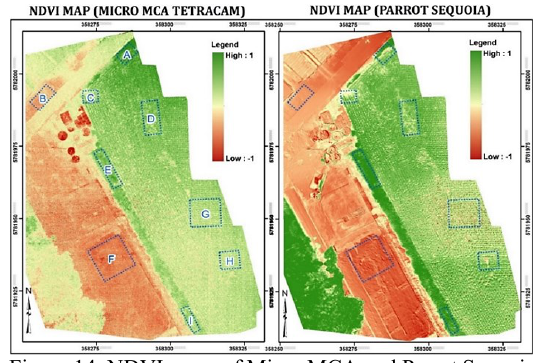
Figure 14. NDVI maps of Micro MCA and Parrot Sequoia The Vegetation Index (VI) response as extracted with PS and Micro MCA are highly correlated; the spatial averages of each zone recorded a positive correlation of 0.86. Despite the differences in GSD and in image quality between the two cameras, the spatial variability of NDVI is highly comparable. datasets is 0.16, with the PS registering higher scores than Micro MCA. As shown in Figure 15, the highest average deviations are seen in zones E and I; Micro MCA depicts comparatively low NDVI values than PS.